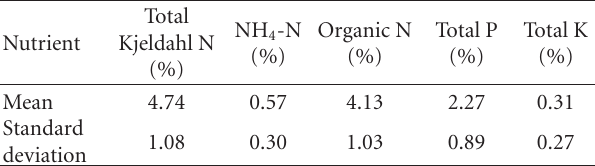
Table 2: Means and variability of nutrient concentrations a in biosolids collected and analyzed in Pennsylvania between 1993 and 1997